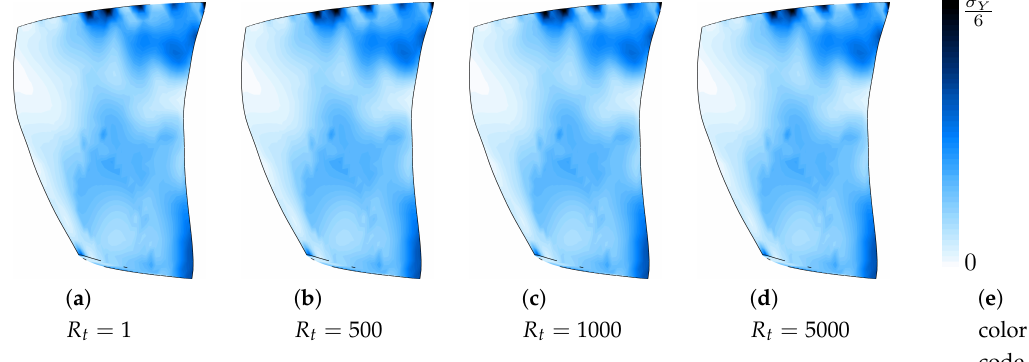
Figure 9. Blade stress fields for different R t values.